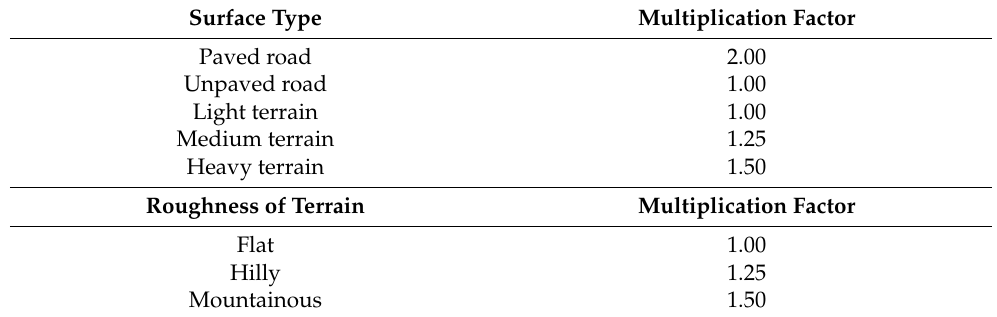
Table 1. Multiplication factors of road